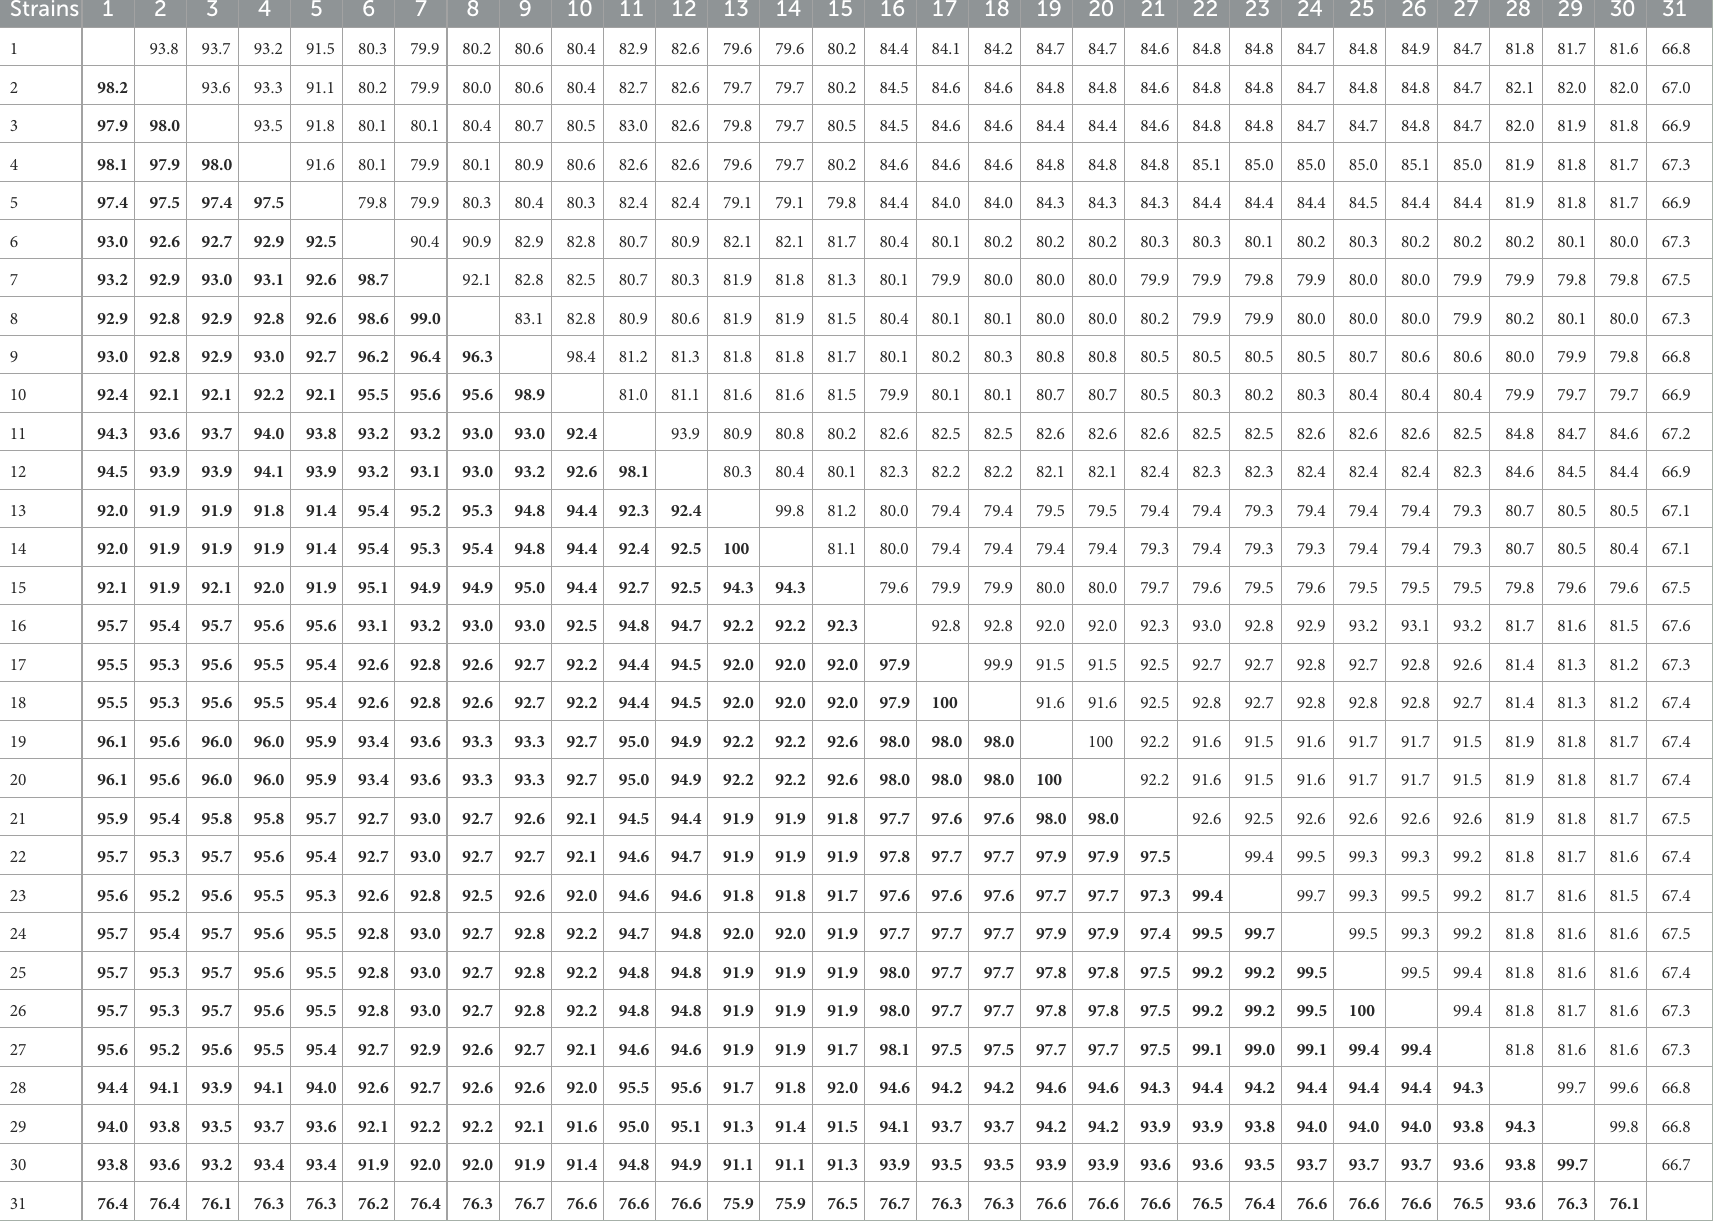
TABLE 3 The sequence identity within the BovHepV polyprotein at the nucleotide (upper right) and amino acid (lower left, boldface) levels calculated using ClustalW method implemented in MegAlign. Strains